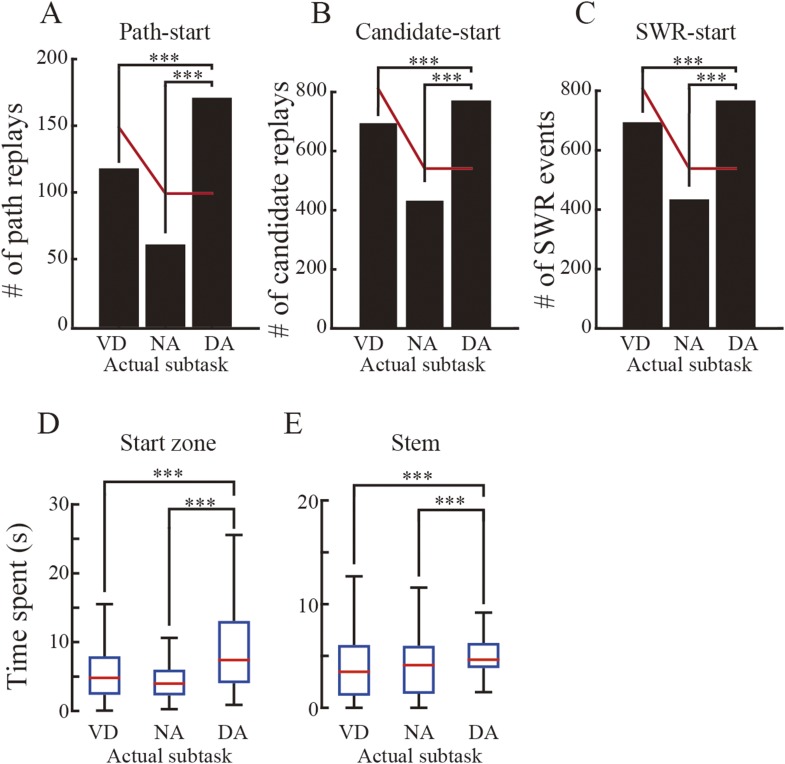
Subtask preference in replays occurring in the start zone, and time spent pausing.(A–C) The number of path-start (A) and candidate (B) replays and SWR events (C) occurring in the start zone, across all rats, as a function of actual subtasks to be rewarded. Red lines as for Figure 7A. ***: p < 0.001 (Chi-square goodness-of-fit test, post hoc multiple binomial tests corrected by the Benjamini and Hochberg procedure). Note that the bias towards the DA subtask can be seen throughout all categories of replay events. (D–E) Time spent pausing (running speed < 2 cm/s) in the start zone (D) and maze stem (E) across all rats, as a function of actual subtasks (red lines: median; blue boxes: first and third quartiles; bars: minimum and maximum values). The rats spent more time pausing during the DA subtask in both the start zone and the maze stem. Kruskal–Wallis test, Tukey's post hoc multiple-comparison, ***: p < 0.001.